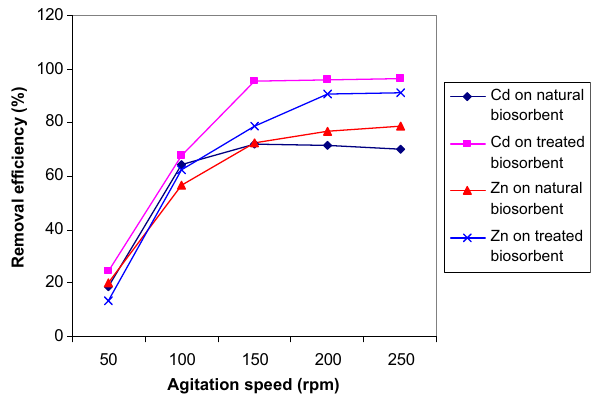
Fig. 7 Effect of agitation speed on Cd and